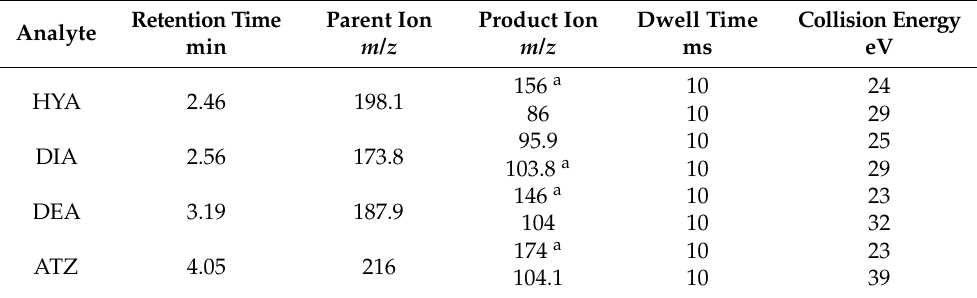
Table 1. MRM conditions for determination of the analytes by